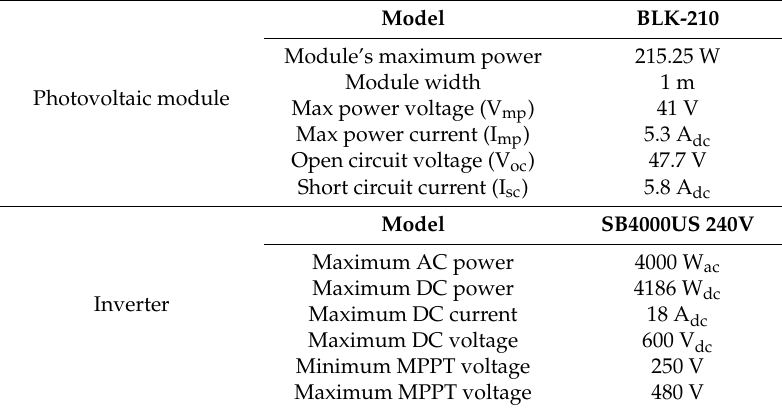
Table 2. Parameters of photovoltaic module and